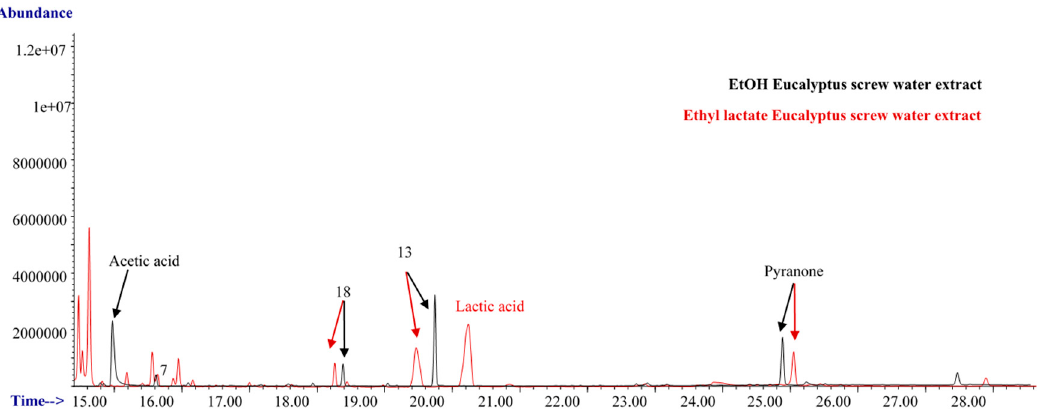
Figure 2. Chromatographic profile obtained for the Eucalyptus screw water. SPME-GC-MS analysis.